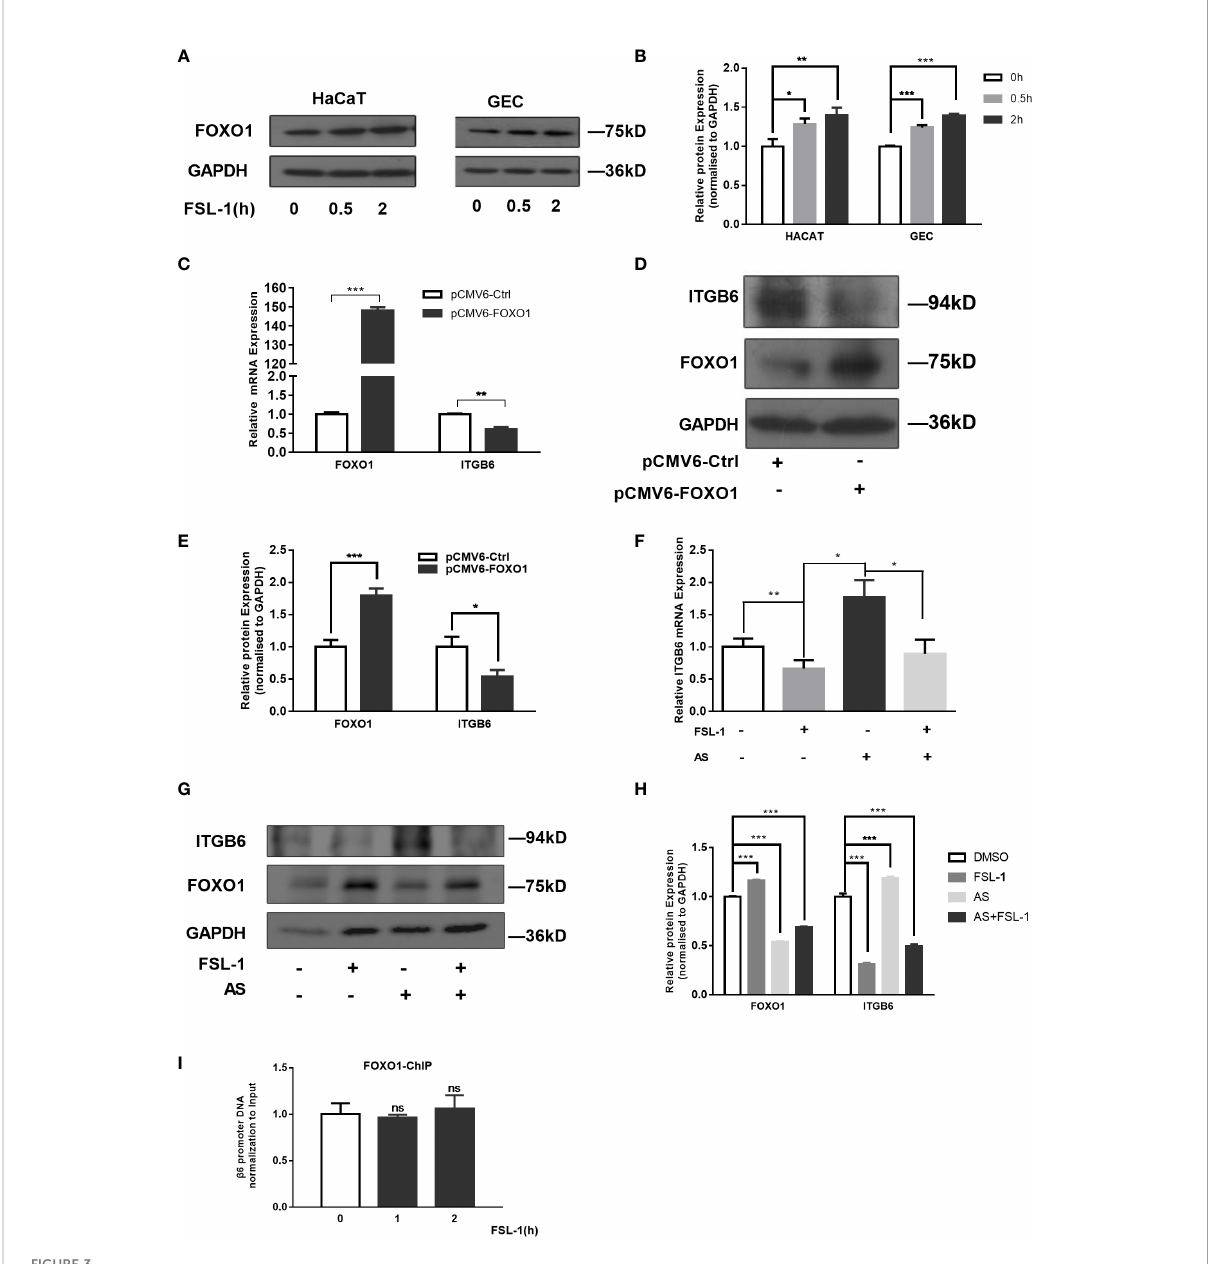
FIGURE 3 FOXO1 is involved in ITGB6 suppression by FSL-1 in HaCaT and GECs. Serum-starved HaCaT and GECs were treated with FSL-1 (100 ng/mL) for 0.5 – 2 h, and the total FoxO1 (A) protein expression levels were analyzed using western blotting. Protein loading was veri fi ed using GAPDH. (B) Densitometric analysis was used to quantify protein bands. Data are presented as mean ± SEM from triplicates, comparised with time zero medium control cells (C) HaCaT cells were transfected with pCMV6-Ctrl or pCMV6-FOXO1 for 48 h. Total RNA was extracted, and the mRNA expression of ITGB6 was detected by RT-qPCR. Data are shown as the mean ± SEM of triplicates and comparisoned with the pCMV6-Ctrl group. (D) Protein expression levels were analyzed using Western blotting. Protein loading was veri fi ed using GAPDH. (E) Densitometric analysis was used to quantify protein bands. Data are presented as mean ± SEM from triplicates and compared with pCMV6-Ctrl group. The effect of the FSL-1 inhibitor AS1842856 (AS) on the expression level of ITGB6 mRNA (F) and protein (G) . HaCaT cells were exposed to FSL-1 (100 ng/mL) for 2 h with or without pre-incubation with AS (1 m M) for 0.5 h. Final concentrations of DMSO were kept constant for all treatment conditions. ITGB6 mRNA levels were determined using qRT-PCR. Data are shown as mean ± SEM of triplicates. Protein levels of ITGB6, FOXO1, and GAPDH (loading control) were measured using western blotting. The blots are representative of three independent experiments with similar results (G) . (H) Densitometric analysis was used to quantify protein bands. Data are presented as mean ± SEM from triplicates. (I) Measurement of FOXO1 binding to ITGB6 promoter. HaCaT cells were treated with FSL-1 at the indicated times, and the binding of FOXO1 to the ITGB6 promoter was detected by ChIP assay. The associated ITGB6 promoter DNA was measured using qPCR. The results were normalized to the input control. Data are shown as mean ± SEM of triplicates. no signi fi cance (ns), compared to the time zero. *P < 0.05, **P < 0.01, ***P <